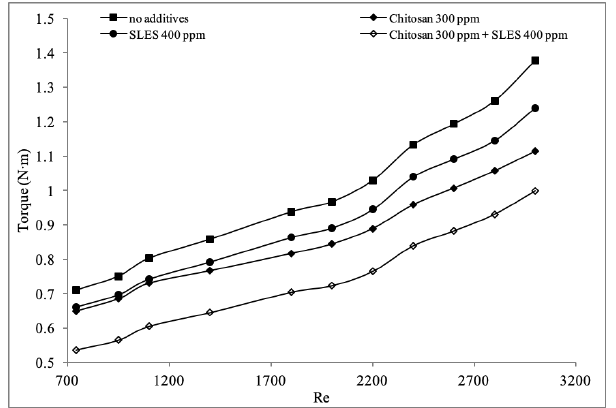
Figure 7: Torque values for chitosan–SLES complexes, pure chi- tosan, and SLES at different rotational speeds